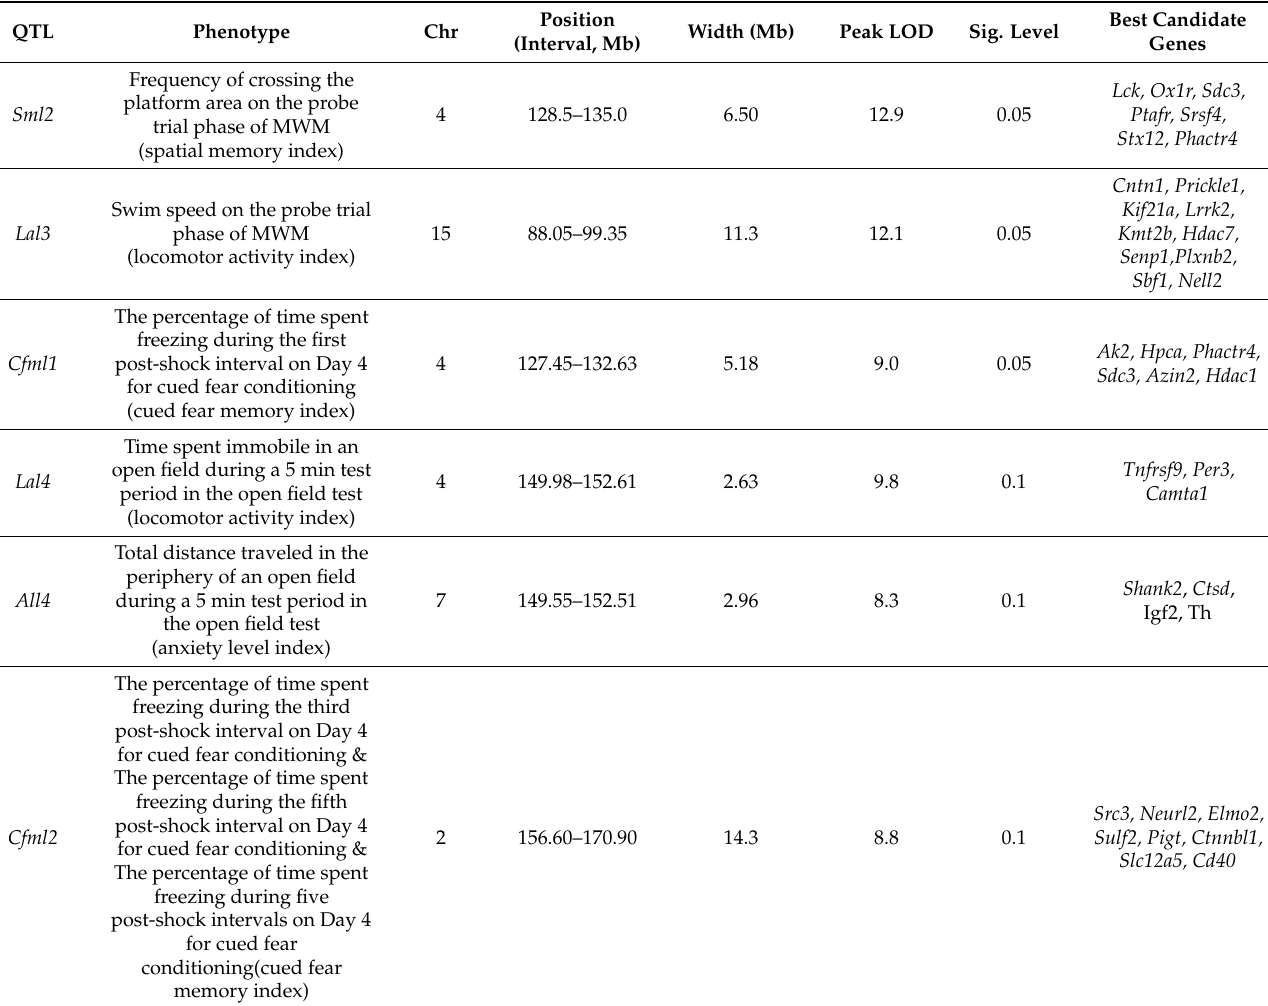
Table 1. Summary of significant behavior QTLs and best candidate